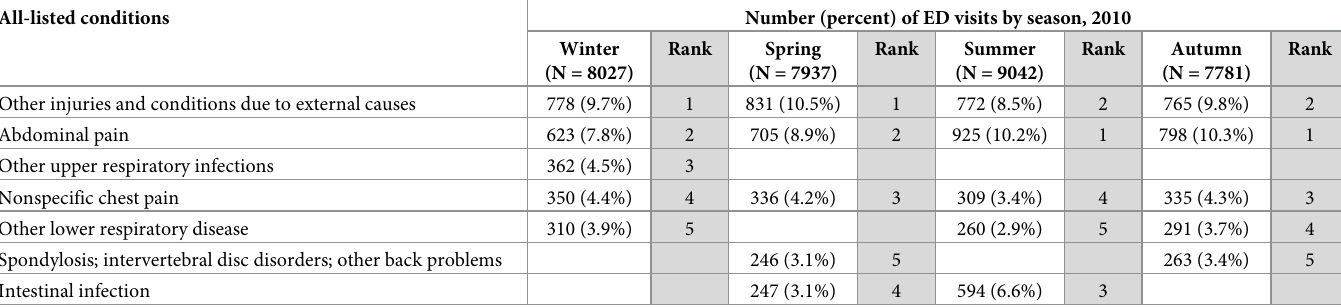
Table 7. Top listed conditions for adult ED visits by season,